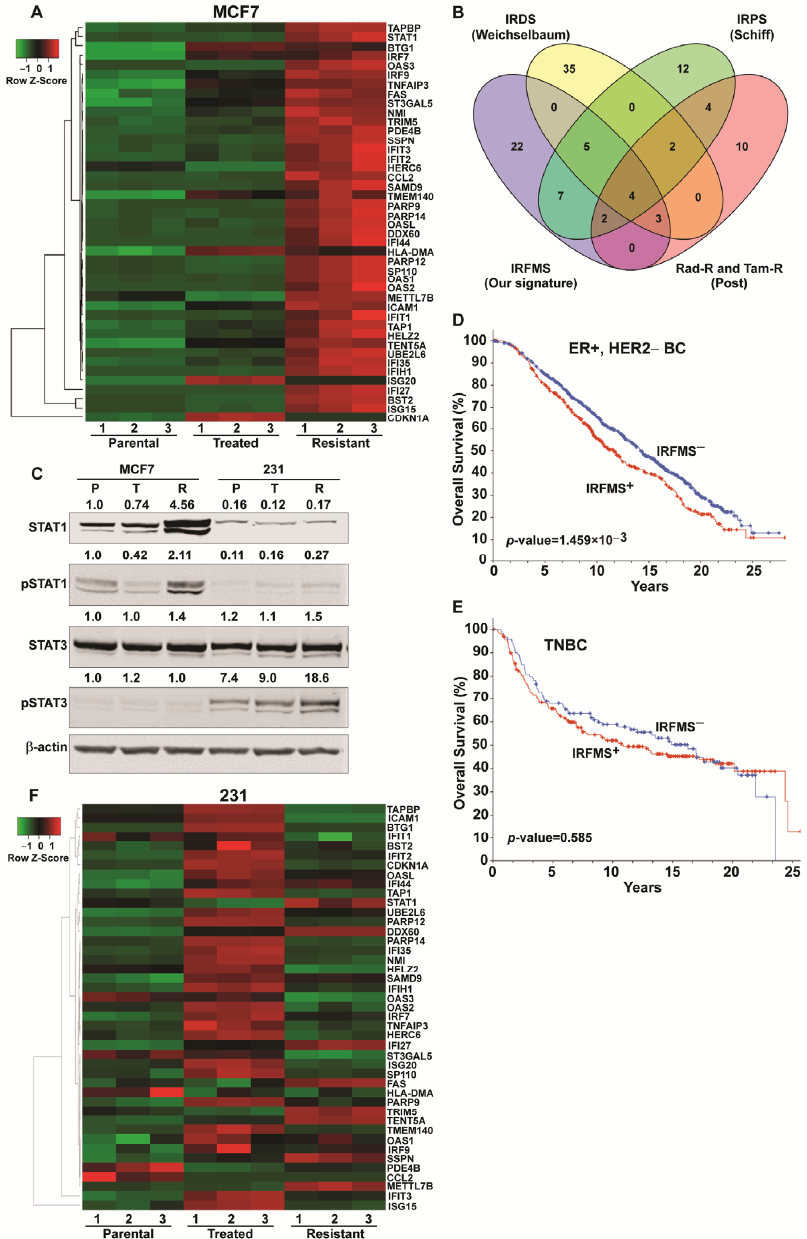
Figure 3. Altered interferon and inflammatory gene expression signaling in FOXM1 inhibitor resistant cells. ( A ) Expression of our IRFMS 43 signature genes in parental (P), treated (T), and resistant (R) MCF7 cells. ( B ) Venn diagram showing genes in our Interferon-Related FOXM1 Inhibitor Resistance Signature (IRFMS) and their overlap with interferon-related signatures reported for CDK4/6 inhibitor Palbociclib resistance (IRPS, Schiff) [12], tamoxifen and radiation resistance (Post) [17], and DNA damage repair/chemotherapy and radiation resistance (IRDS, Weichselbaum) [18]. ( C ) Western blots showing levels of STAT1, pSTAT1, STAT3, and pSTAT3 in MCF7 or 231 parental (P), 24 h NB73 treated (T), and NB73 resistant (R) cells. Numbers above the blot indicate level corrected for loading control β -actin. Level in MCF7 P cells is set at 1.0. Original blots see Figure S3. ( D ) IRFMS predicts poor prognosis in patients with ER-positive, HER2-negative breast cancer. Kaplan–Meier curves of overall survival of patients with ER-positive, and HER2-negative breast cancer in the METABRIC dataset (n = 1236) stratified by the mean IRFMS score as described in Methods. Logrank p-value is shown. ( E ) Interferon Related FOXM1 Inhibitor Resistance Signature (IRFMS) does not predict prognosis in patients with triple negative breast cancer. Kaplan–Meier curves of overall survival are shown, n = 320 from METABRIC. Clinical samples are stratified by the mean IRFMS score as described in Methods. Logrank p-value is shown. ( F ) Expression of our IRFMS 43 signature genes in MDA-MB-231 parental (P), 24 h short-term NB73 treated (T), and resistant (R) cells.